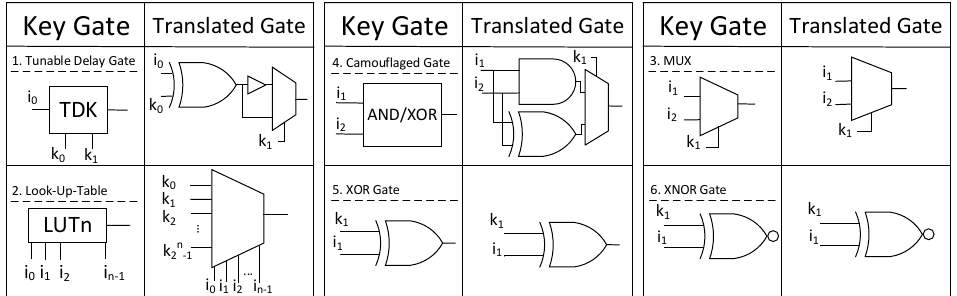
Figure 5: Translation Table for Converting the Camouflaging and Obfuscation Gates to Key Programmable Gates